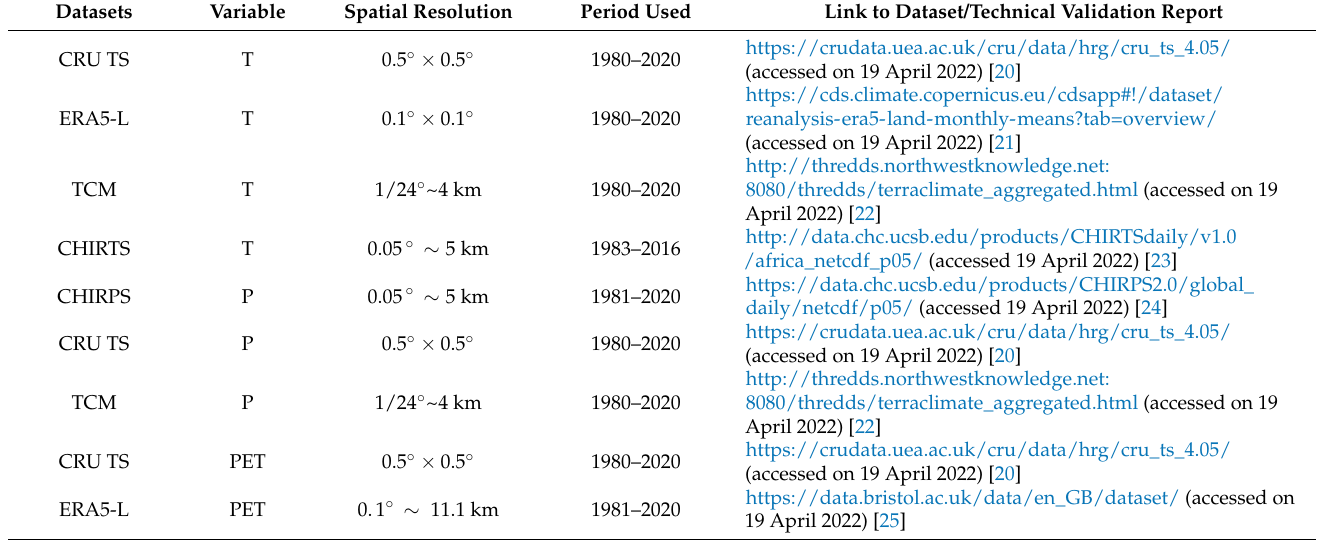
Table 1. Temperature, precipitation, potential evaporation, and potential evapotranspiration datasets